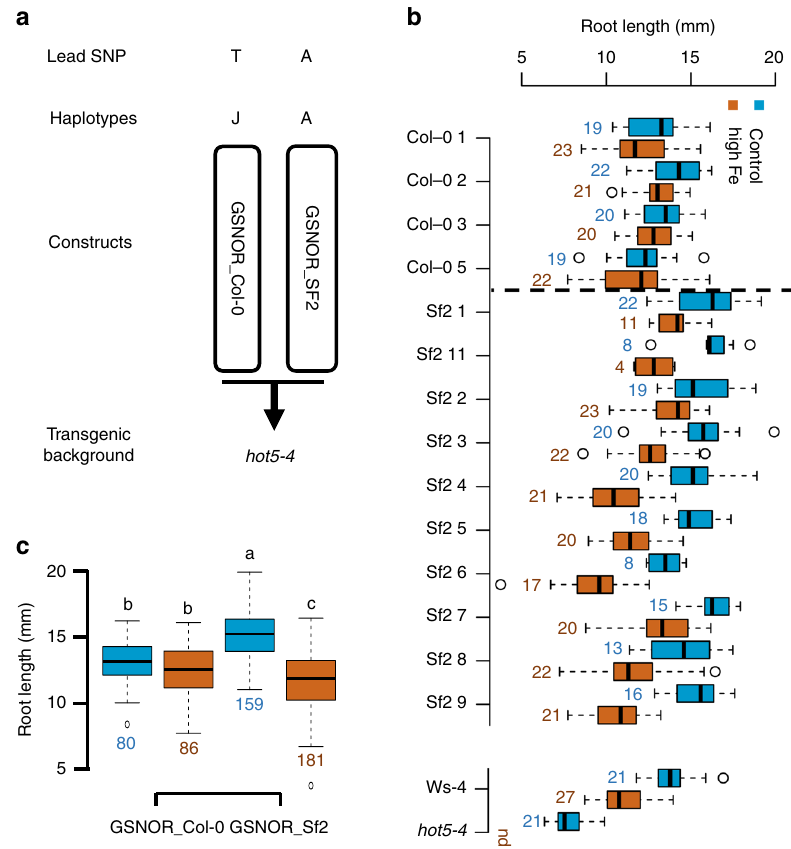
Fig. 4 Natural GSNOR variants cause variation of root growth tolerance to high Fe. a Schematic of the constructs for GSNOR variants to generate transgenic lines. b Box plots for root length of T2 seedlings of ten GSNOR_Sf-2 lines and four GSNOR_Col-0 lines at day 6. hot5-4 and Ws-4 were included as the comparison for high Fe sensitivity. Not detected (nd) indicates no root growth of hot5-4 was observed at 350 µ M Fe conditions. c Box plots for the mean of ten GSNOR_Sf-2 lines and four GSNOR_Col-0 lines shown in b . Numbers below and next to boxes in b, c indicate the number (n) of T2 seedlings used for each line in the analysis. Different letters indicate signi fi cant difference according to Tukey ’ s HSD comparison ( p -value < 0.05). The Source data of Fig. 4b are provided in a Source Data fi